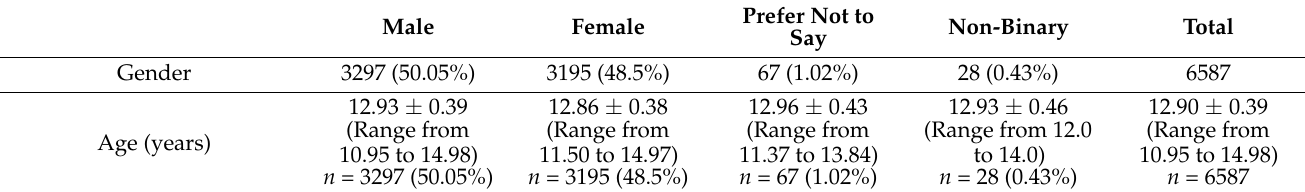
Table 2. Participant characteristics by gender reported as mean ± S.D, number ( n ) and frequency (%). Male Female